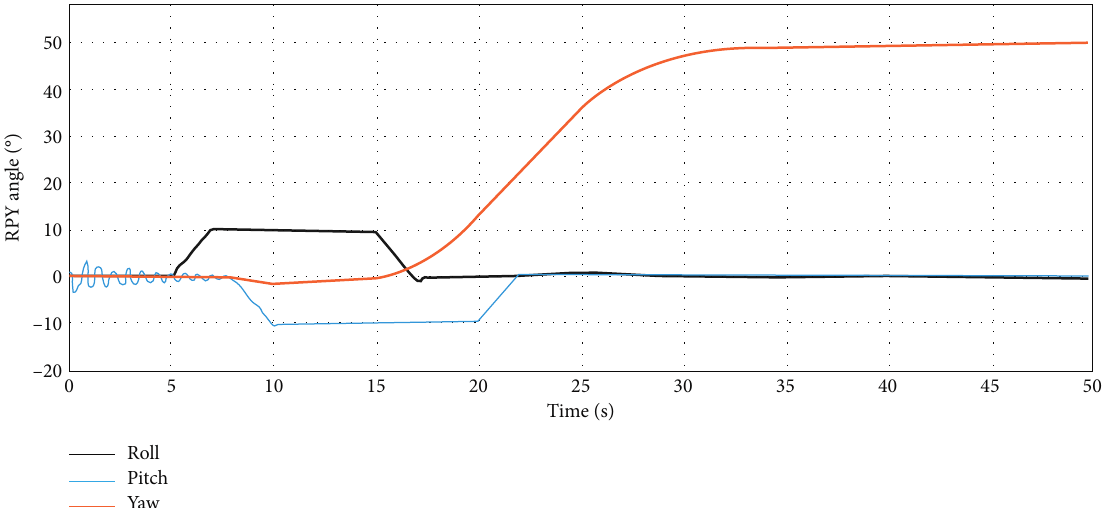
Figure 9: RPY output response curve of PID controller under interference.